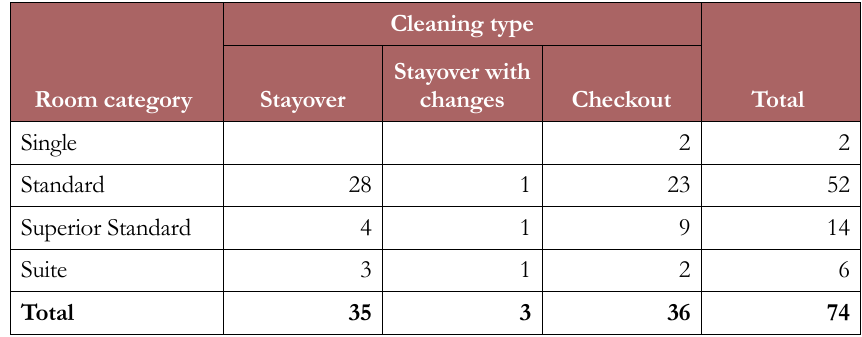
Table 2. Number of observations by room category and cleaning